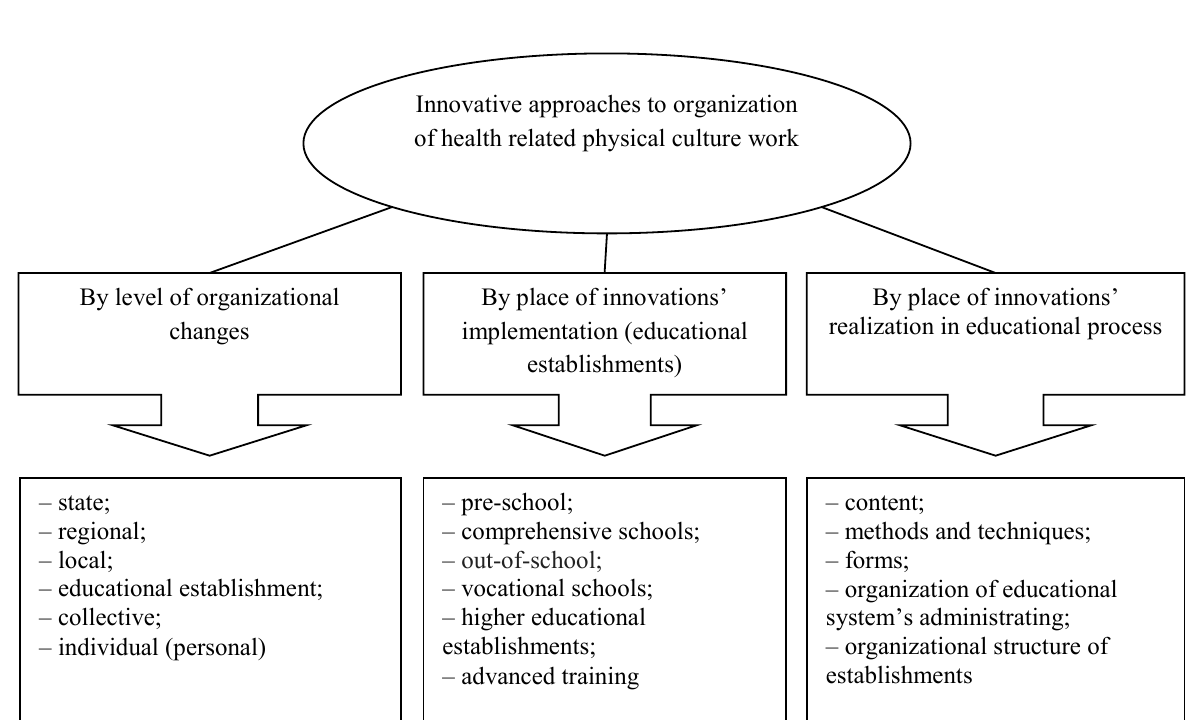
Fig. 2. Classification of innovative approaches to organization of health related physical culture